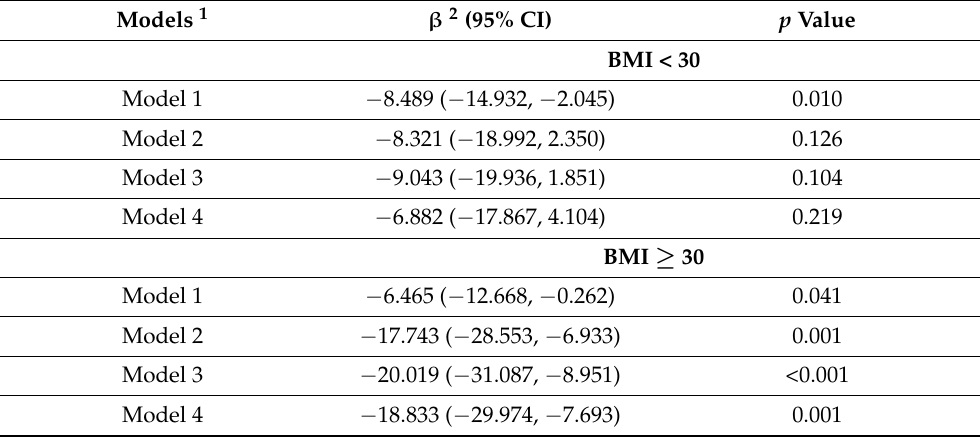
Table 4. Association between serum klotho concentration and sagittal abdominal diameter with